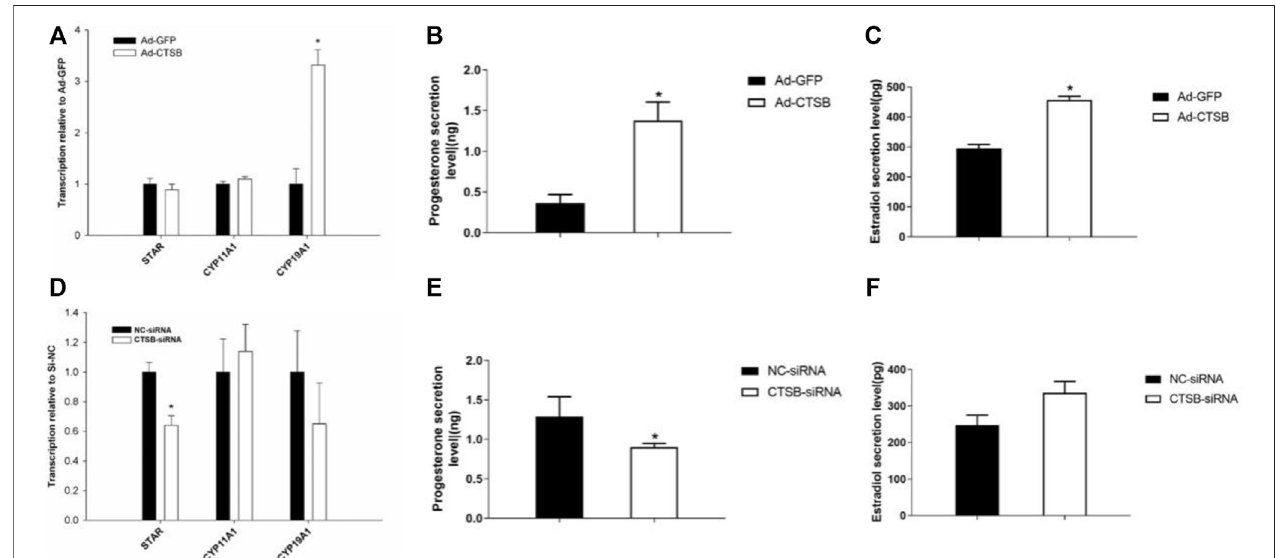
FIGURE7| EffectsofCTSBoverexpressionandinterferenceonprogesteroneandestradiolsecretioninrabbitGCS.Transcriptionofkeygenesrelatedtohormone secretion in GCS with CTSB overexpression (A) or interference (D) . Level of progesterone and estradiol secretion in rabbit GCS after CTSB overexpression (B,C) and interference (E,F) . Each experiment had three biological replicates and the results are expressed as the mean ± SE. * p < 0.05, ** p < 0.01.